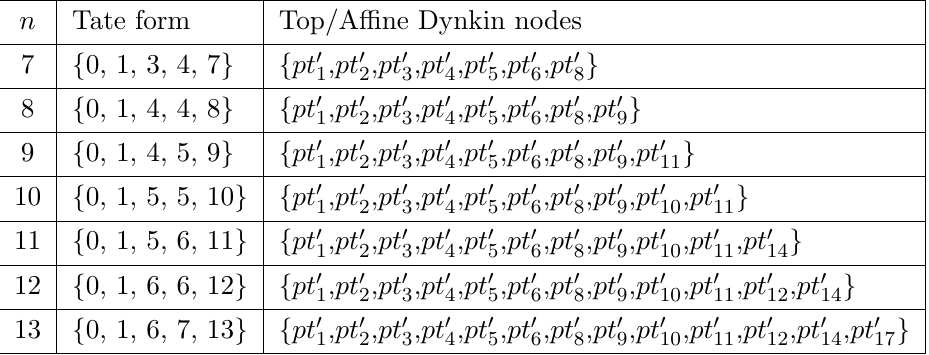
1 ; 2 ; 3 ; 4 ; 5 ; 6 ; 7 ; 8 ; 9 ; 10 ; 11 ; 12 ; 13 ; 14 ; 15 ; 16 ; 17